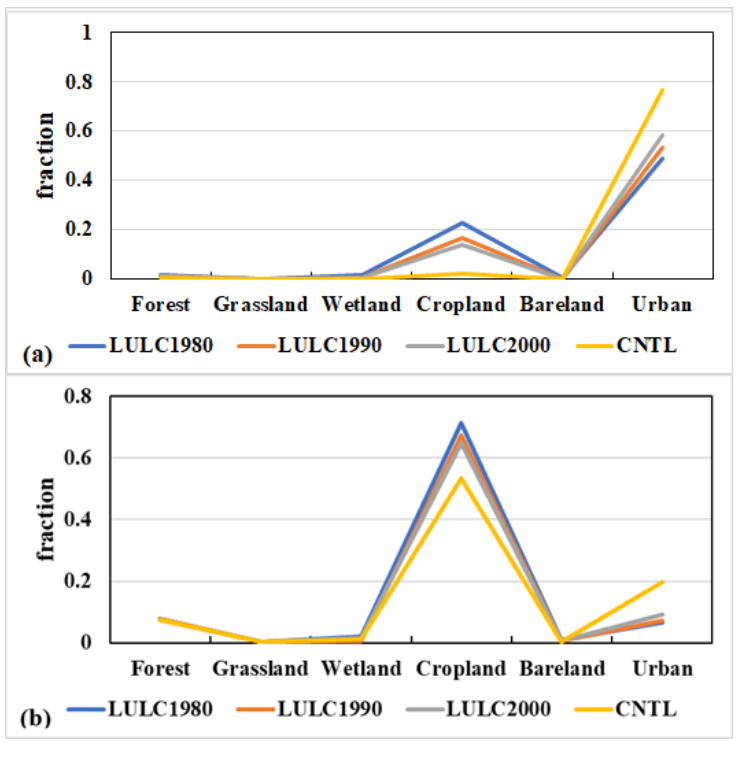
Figure 10. The fraction of each LULC type in different periods within the third ring road ( a ) and the fraction of each land cover type outside the third ring road but inside the administrative boundary of Wuhan ( b ). Table 5. The averaged LST for each LULC type in different simulations (Unit: K).